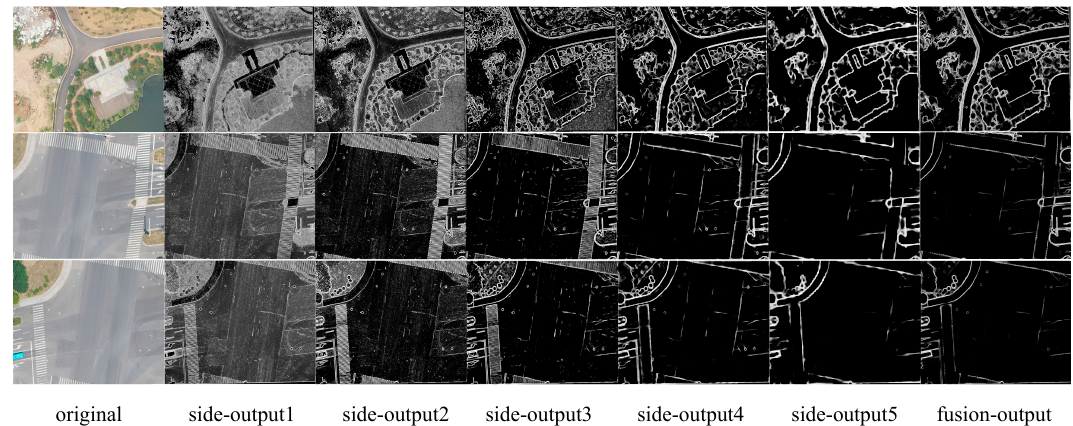
Figure 5. Outputs of MON detection.